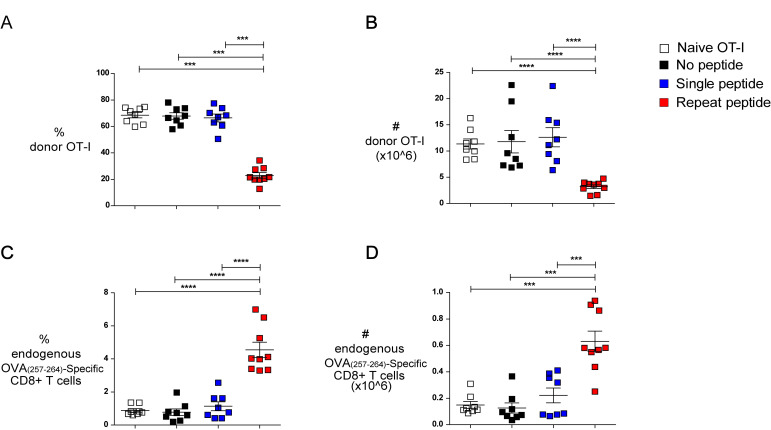
Repeat peptide stimulation decreases in vivo CTL expansion capacity.OT-I CD8+ T cells were cultured without peptide stimulation (no peptide), one-time stimulation (single peptide) or daily stimulation (repeat peptide) and sorted on day 5. Live CD8+ T cells were adoptively transferred into wild type mice which were then infected with the OVA(257–264)-expressing influenza virus WSN-OVA. Freshly isolated OT-I CD8+ T cells from a naïve mouse were also transferred (naïve OT-I). Lungs were harvested on day 10 post infection. (A) Frequency of donor CD45.1+ OT-I CD8+ T cells within total lung CD8+ T cells shown. (B) Absolute number of lung donor CD45.1+ OT-I CD8+ T cells depicted. (C) Frequency of endogenous CD45.2+ OVA-specific CD8+ T cells within the total lung CD8+ T cells shown. (D) Absolute number of endogenous CD45.2+ OVA-specific CD8+ T cells shown. Each symbol represents one animal (n = 8–9) from n = 3 independent experiments. Line depicts mean ± SE. To determine significant differences between the different animal groups, a Mann-Whitney U test was used except for data in (A) (ANOVA with Tukey’s post hoc test). ***P<0.001, ****P<0.0001.